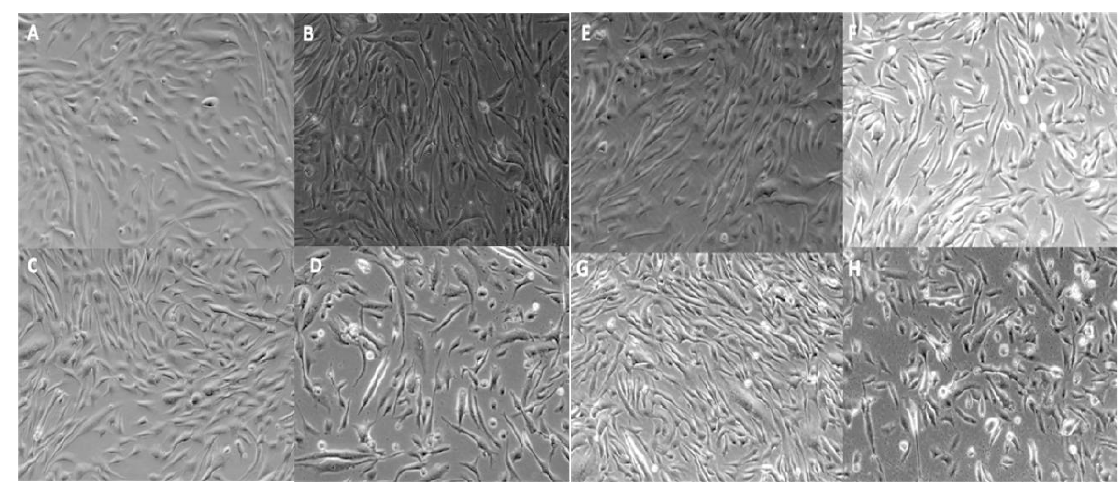
Figure 3. Qualitative cell viability assessment by light microscopy of hSkMCs transfected with lipoplex formulations C20-20/Chol/PMO AO ( A – D ) and C30-20/Chol/PMO AO ( E – H ) at (+/ − ) molar charge ratios of 0.05:1 ( A , E ), 0.1:1 ( B , F ) 0.25:1 ( C , G ) and 0.5:1 ( D , H ) at 24 h.